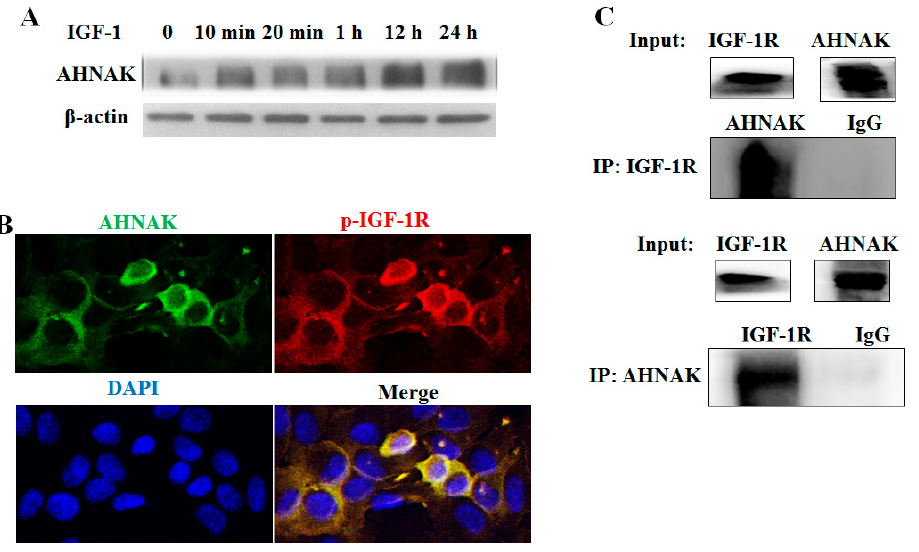
Figure 5. Identification of AHNAK as a novel IGF-1R-interacting protein: ( A ) Western blotting experiments showed that IGF-1 induced AHNAK expression. ( B ) Confocal microscopy scans of immunofluorescence double staining showed that AHNAK (green) co-localized with IGF-1R (red) in serum-starvation-treated HepG2 cells. ( C ) Co-immunoprecipitation and Western blotting experiments showed interactions between AHNAK and IGF-1R.